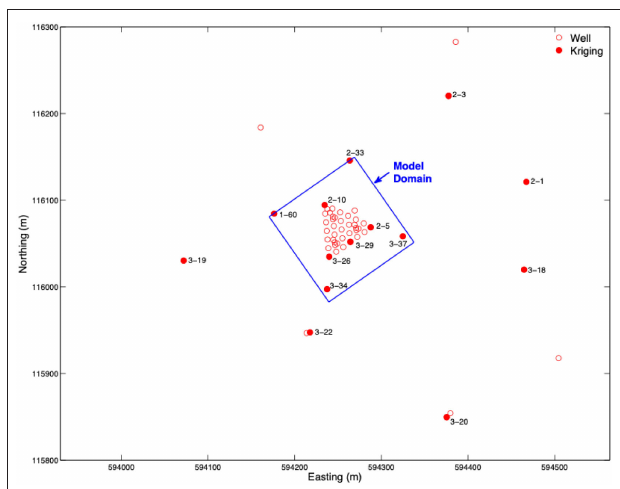
FIGURE 1 | The injection well-field and model domain. All wells shown in filled circles were used for kriging the hourly flow boundary conditions in reactive transport